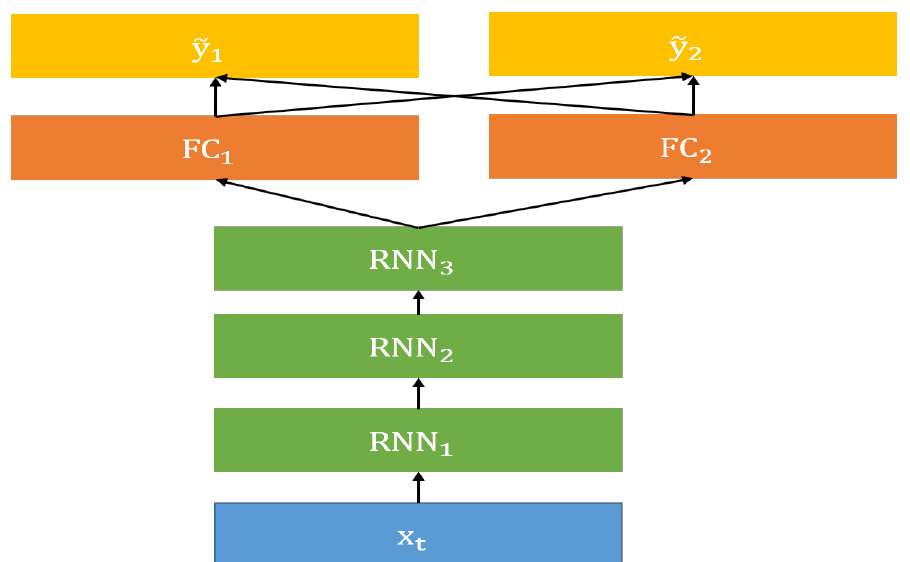
Figure 3. Stacked RNN baseline architecture. Baseline model consists of three layers of multiple RNNs and a fully connected (FC) layer. Individual sources have their own FC layer, and the weight and bias parameters of RNN layers are